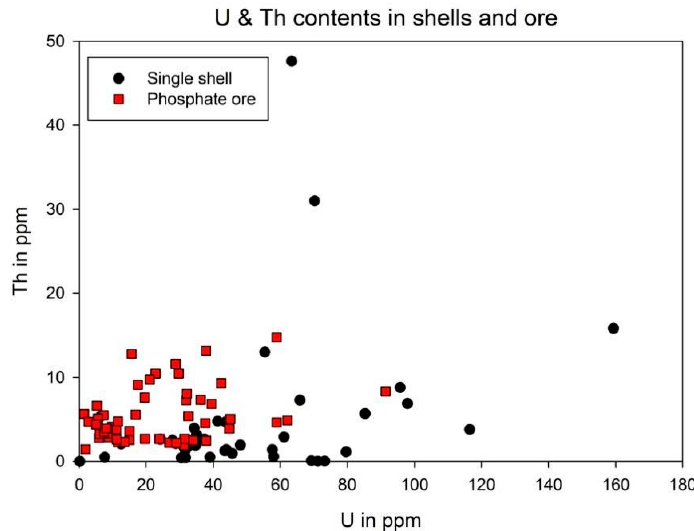
Figure 11. Concentrations of U and Th in single brachiopod shells and in brachiopod sandstone–phosphorite ore as analyzed by ICP-MS. Unpublished data from the University of Tartu and Tallinn University of Technology.